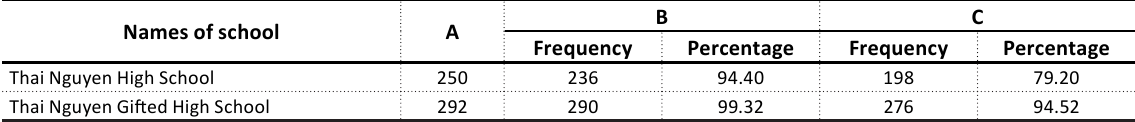
Table 1. The number of year 12 students in Thai Nguyen province with a mobile Names of